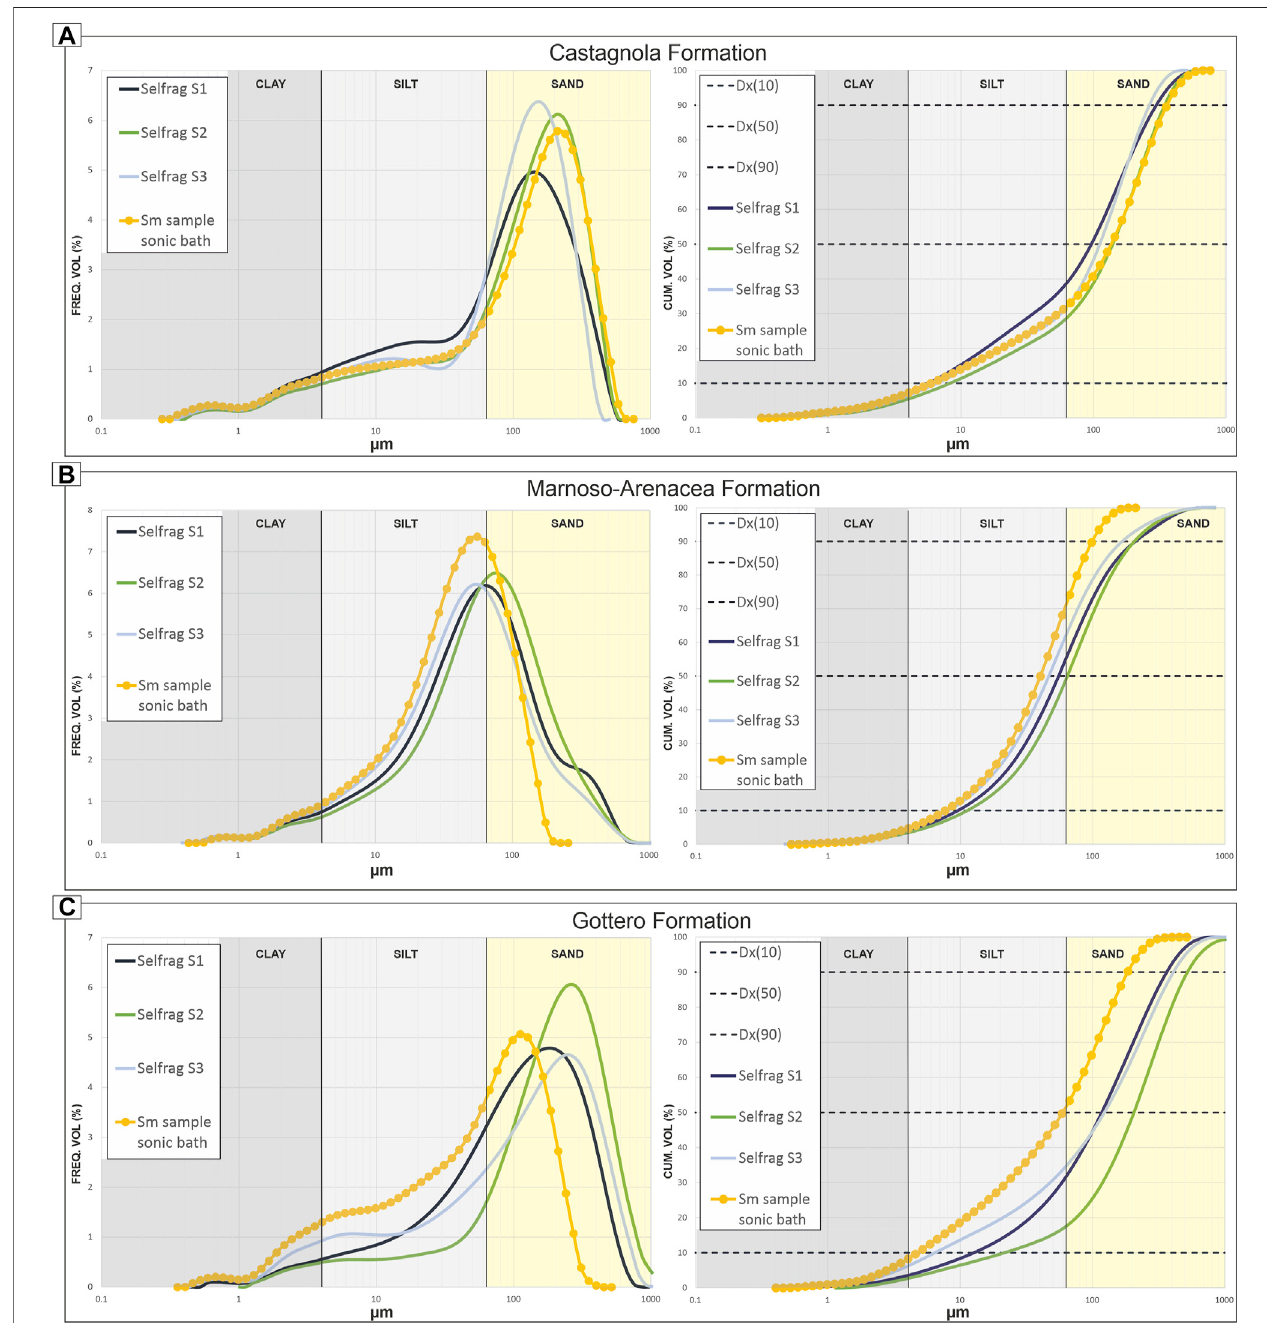
FIGURE11| Volumefrequencyandcumulativefrequencygraphsfor fi eldsampleshowingcomparisonofsamplesdisaggregatedinSELFRAGandsplitwitharif fl e splitter (see text for details) and small subsample (yellow). (A) Example from the Castagnola formation, VI 208 S2 from the lower H1 division of a hybrid event bed. (B) Example from the Marnoso-Arenacea Formation, Location Coniale 2, Bed 0.4 (Amy and Talling, 2006), Sample 7, interpreted as part of the upper debritic portion of a hybrid event bed. (C) Example from the Gottero formation, GOT A B13 S3 from the matrix of a debritic portion, H3, of a hybrid event bed. For detailed results Supplementary Table S1 , for p -values Supplementary Table S2